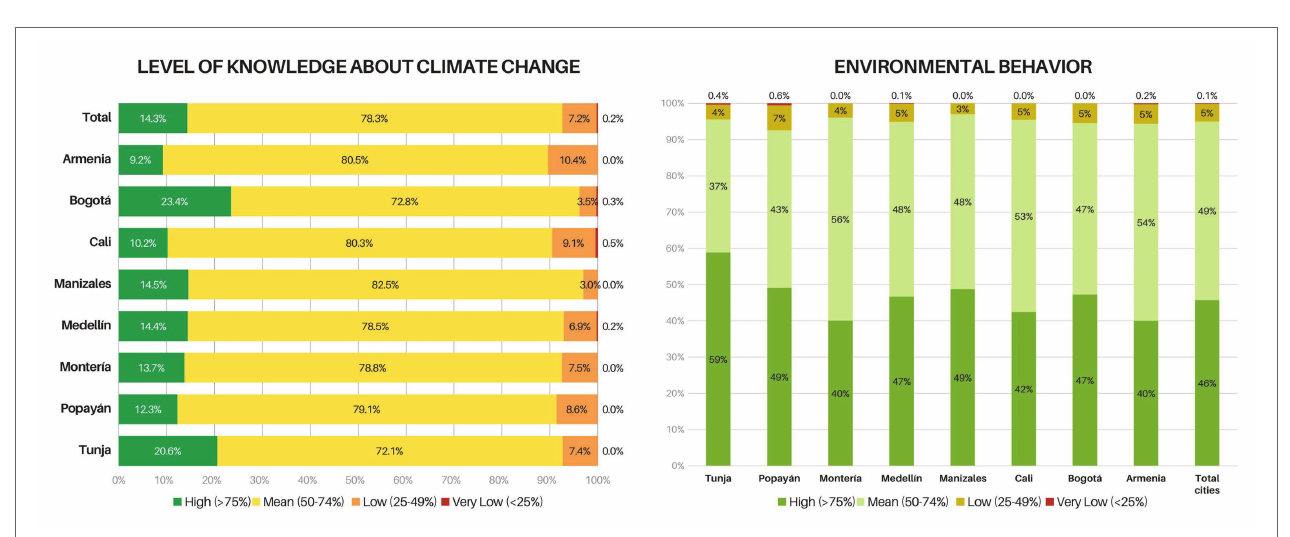
FIGURE 2 | Knowledge about climate change (left) and PEBs (right) by cities in Nicaragua.